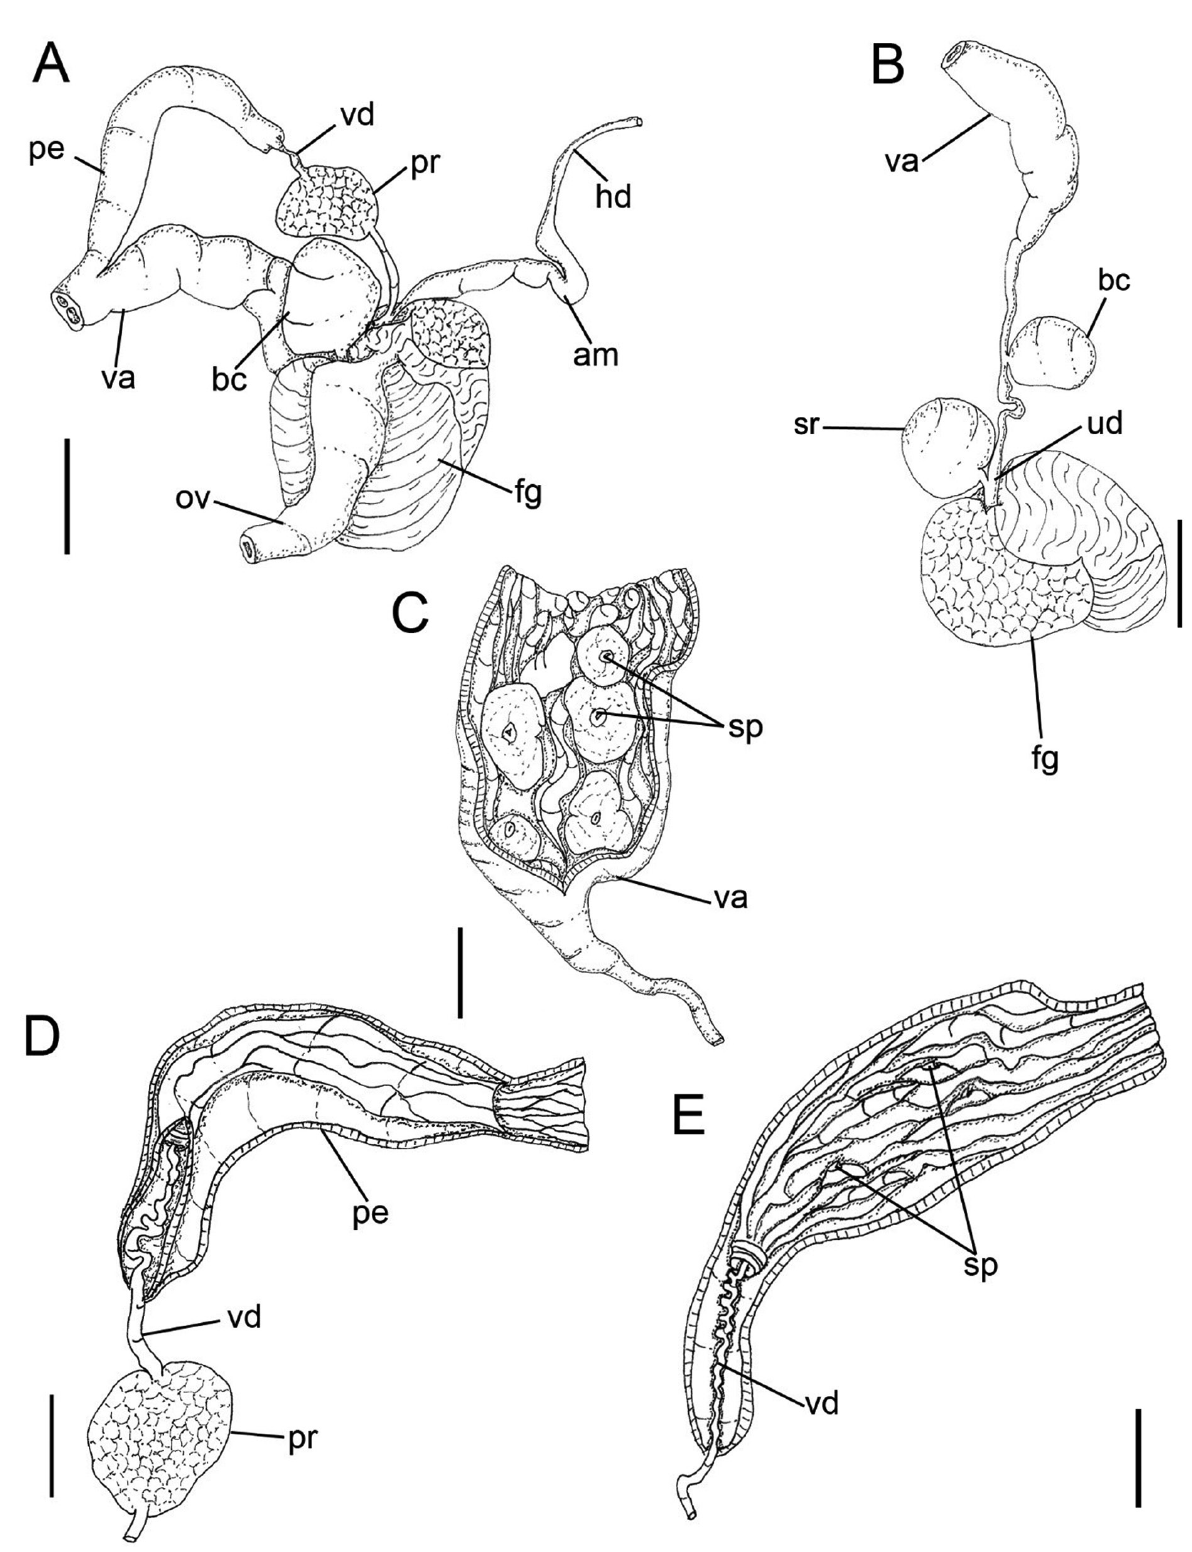
Figure 4. Platydoris angustipes . Reproductive system A general view B detail of connection of uterine duct C detail of vagina’s spines D detail of internal part of insertion of vas deferens E detail of penis’s spines. Scale bars: 2 mm ( A, B ); 1 mm ( C–E